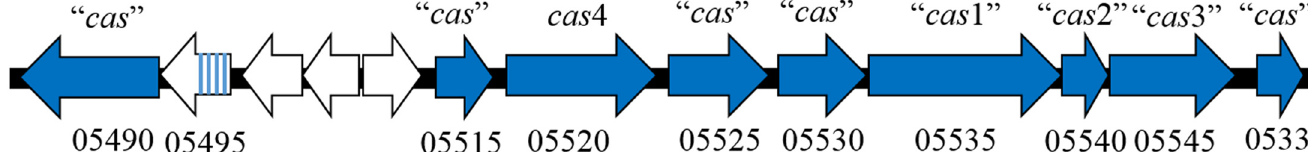
Fig 7. Schematic representation of CRISPR (clustered regularly interspaced short palindromic repeats)/ cas system in “ Candidatus Liberibacter asiaticus ” Strain A4. The CRISPR repeats are depicted by four vertical blue lines at locus 05495. Open reading frames (ORFs) are represented by arrow boxes with locus numbers listed. ORFs with no predicted functions are indicated by white arrows (locus number omitted for simplicity). ORFs with conserve domains of DNA/RNA enzymes were predicted as “ cas ” genes and indicated by blue arrows. Arrow directions represent ORF directions. The cas 4 assignment to ORF 05520 was determined by significant match to orthologues in Conserve Domain Database. Genes “ cas 1-3 ” were proposed mainly based on similar protein functions.